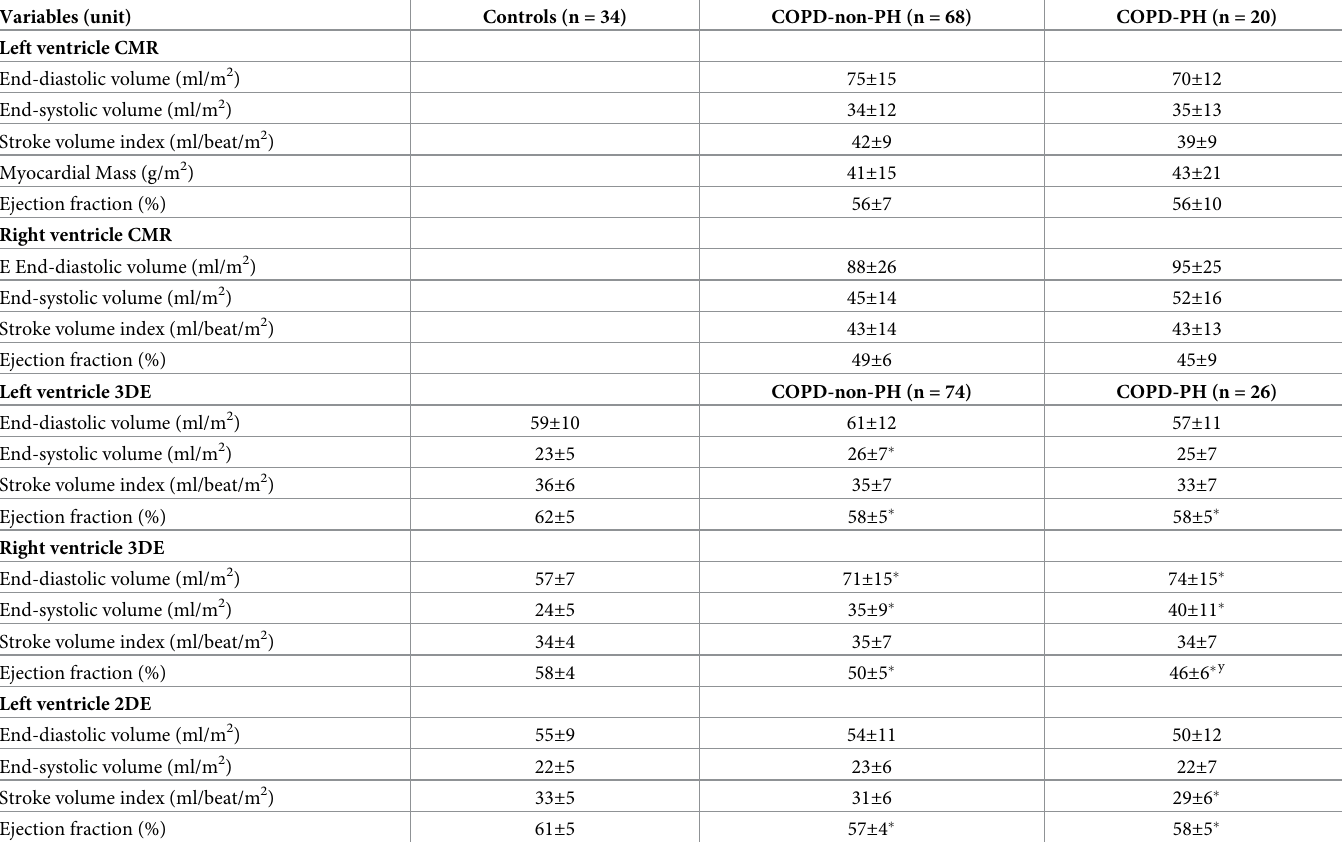
Values are mean ± SD. CMR: Magnetic resonance imaging, 3DE and 2D: Three and two dimensional echocardiography, respectively, � significantly different from controls, y significantly different from